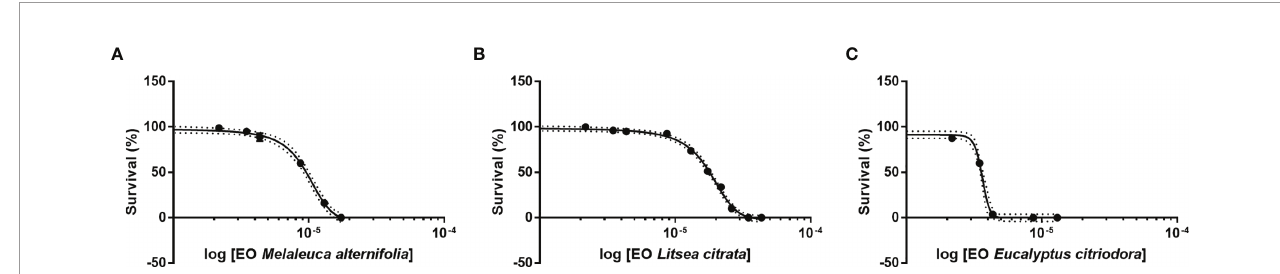
FIGURE 1 | Toxicity of three essential oils ( Melaleuca alternifolia, Litsea citrata, and Eucalyptus citriodora ) on Artemia franciscana . Survival was recorded 48 h after EOs treatment. (A) Melaleuca alternifolia, (B) Litsea citrata, (C) Eucalyptus citriodora . X axis represented log transformed concentrations data. The error bars represented the standard error of four replicates. Dotted line on charts represents 95% con fi dence